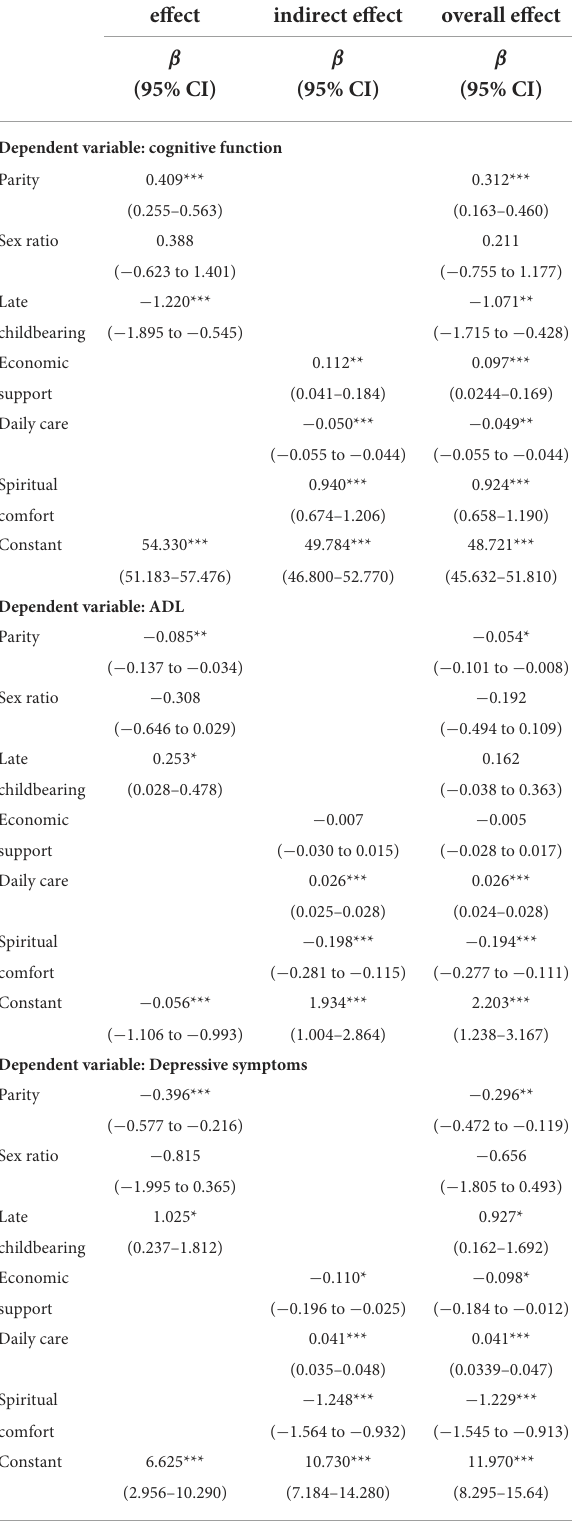
TABLE 4 Linear regression models examining the association between reproductive history and multidimensional health by